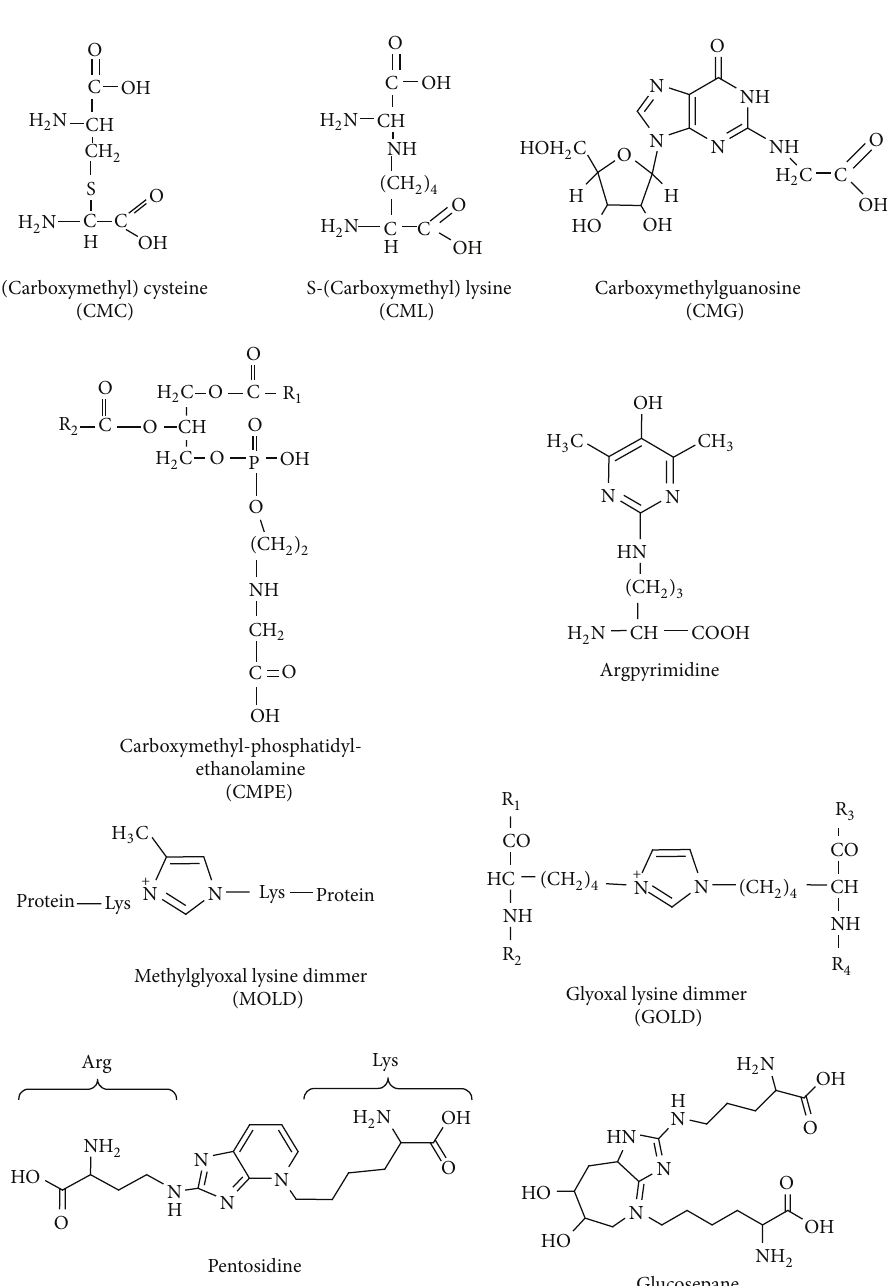
Figure 4: The structures of most common biological advanced lipoxidation and glycation end